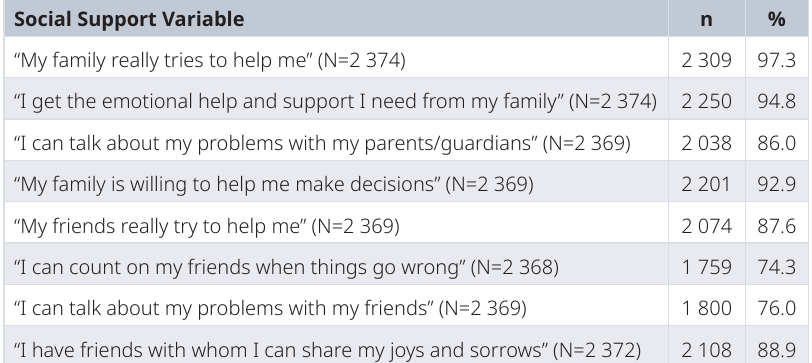
Table 3. Participant responses to social support